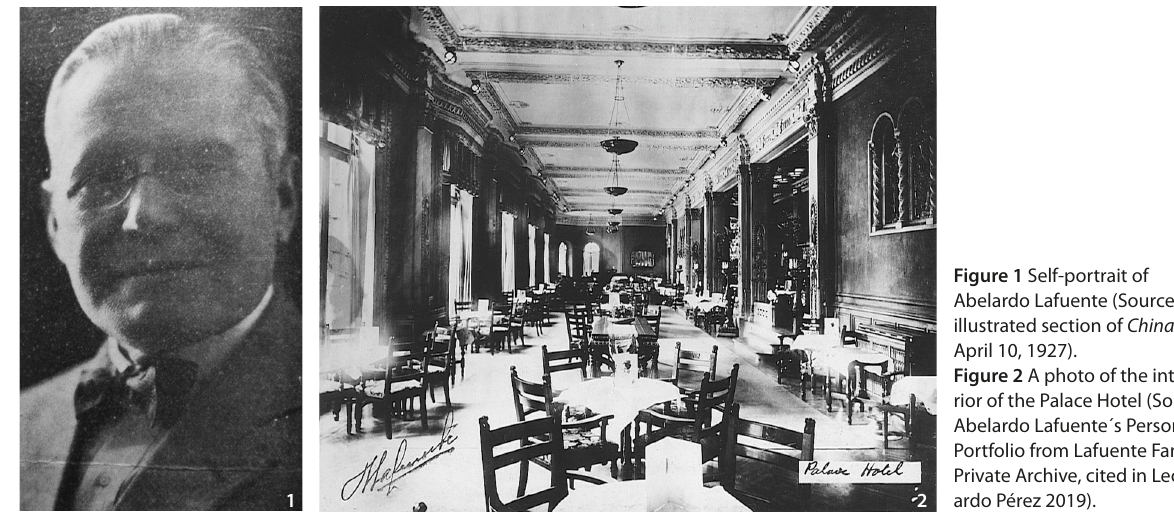
Figure 1 Self-portrait of Abelardo Lafuente (Source: the illustrated section of China Press , April 10, 1927). Figure 2 A photo of the inte- rior of the Palace Hotel (Source: Abelardo Lafuente´s Personal Portfolio from Lafuente Family Private Archive, cited in Leon- ardo Pérez